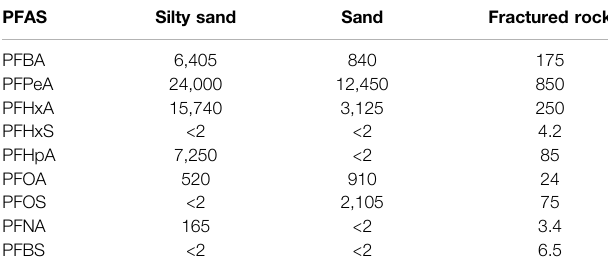
TABLE 1 | Summary of maximum concentrations of detected PFAS within the three aquifers prior to the injection of the CAC. All units ng/L. PFAS